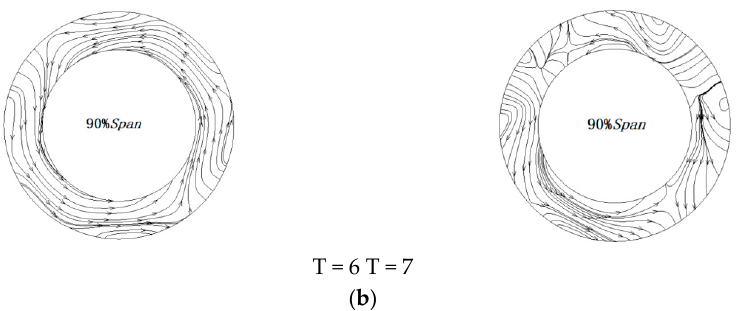
Figure 23. The suction streamline of vaneless diffusers in different times: ( a ) streamline of the 90% diffuser blade height at different times when the radius ratio is 1.8; ( b ) streamline of the 90% diffuser blade height at different times when the radius ratio is 1.5.